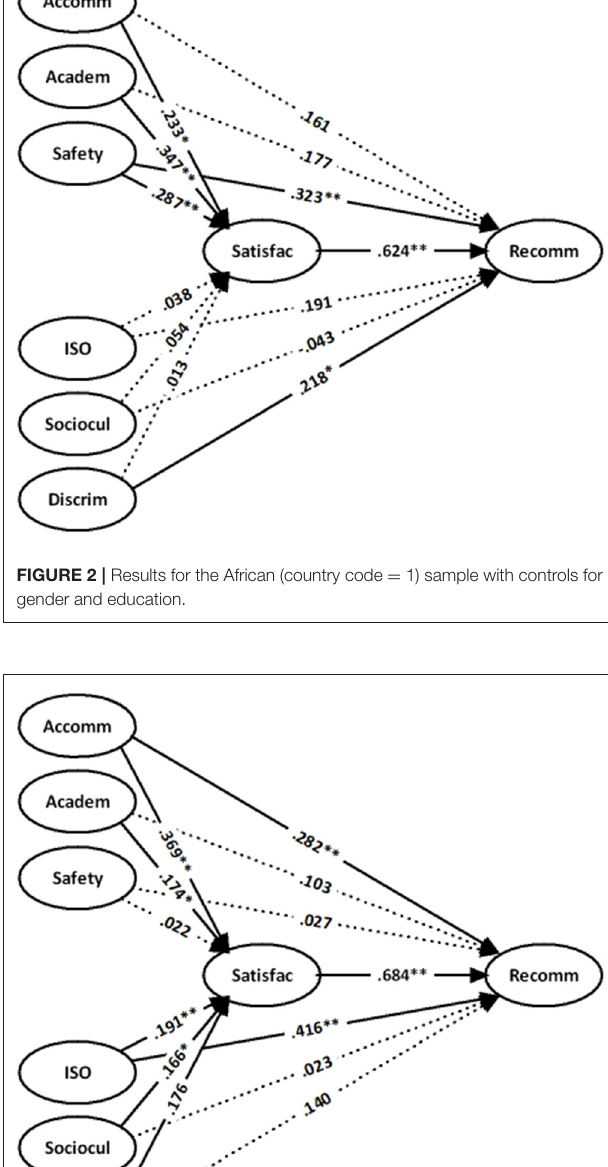
safety and satisfaction; β = 0.022 ( t = 0.324), ns] relationships